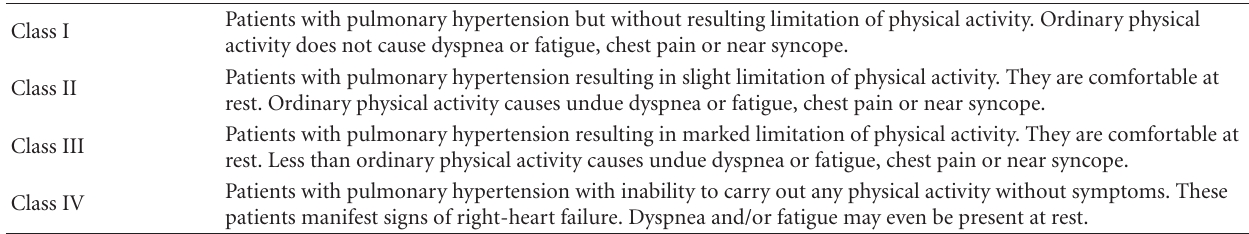
Figure 2: Clinical findings in a patient with chronic right-heart insu ffi ciency and severe pulmonary hypertension. Table 5: Functional classification of pulmonary hypertension (WHO 1998) [28].